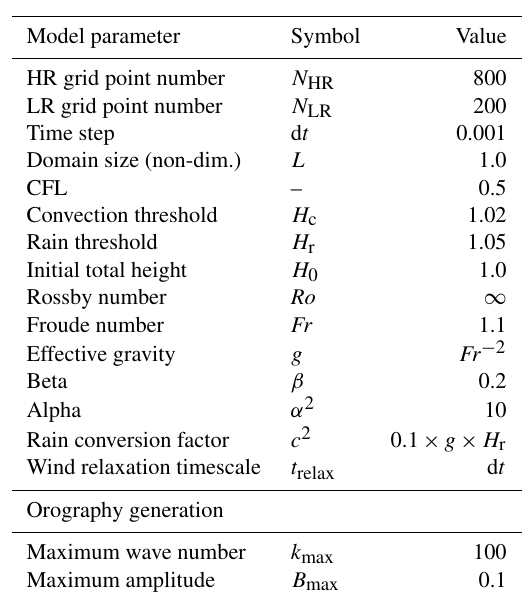
Table 1. Model setting